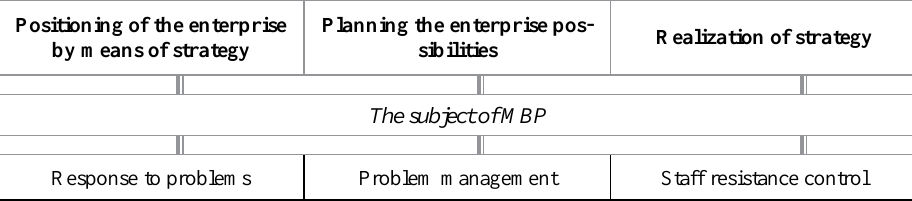
Fig. 1. The subject of MBP as the systematic approach to the strategic variables